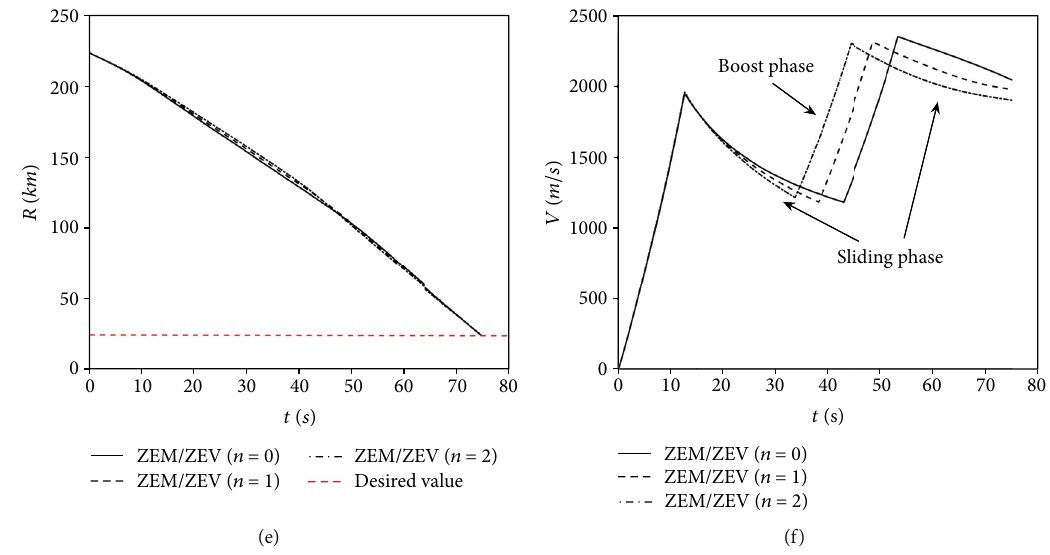
Figure 7: Changes in the fl ight parameters for interception using di ff erent midcourse guidance methods under multiple constraints based on predictions of the trajectory. (a) Normal overload change curve. (b) Lateral overload change curve. (c) Curve of the track angle curve. (d) Curve of the track declination angle. (e) Relative distance curve. (f) Velocity